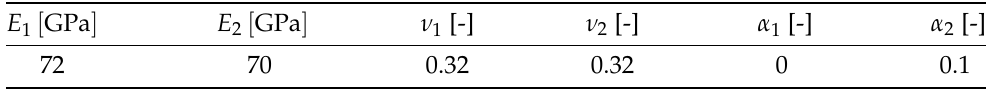
Table 1. Material properties for the trailing edge